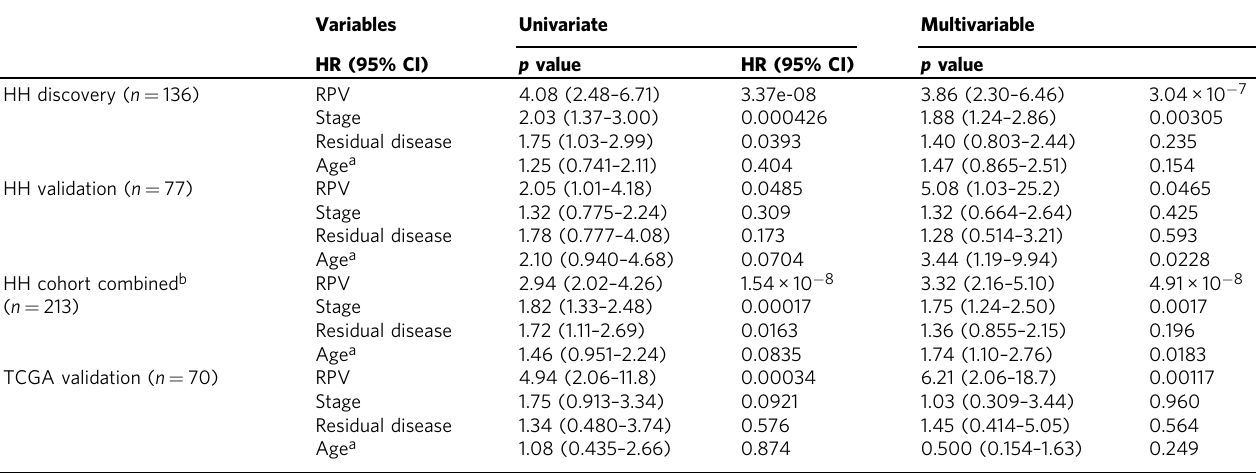
Table 2 Summary of Cox regression analysis of RPV in three datasets. RPV was used as a continuous variable in the Cox regression analysis